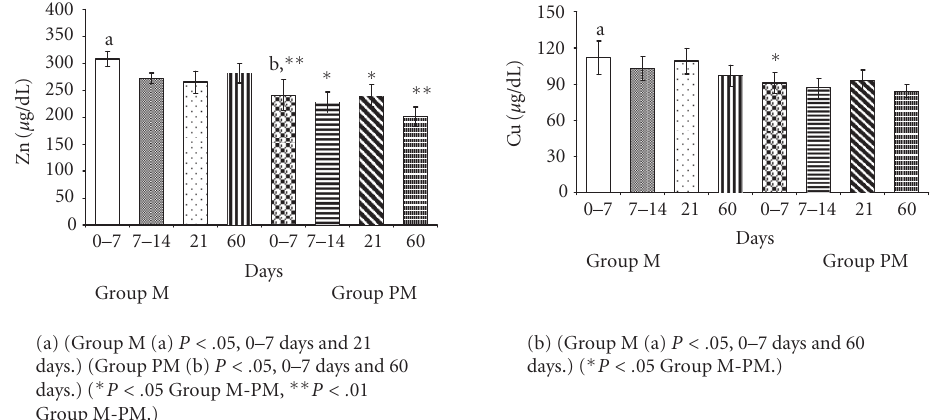
Figure 2. Comparison of trace elements (Zn, Cu) levels in milk from mothers of mature (group M) and premature (group PM) infants.